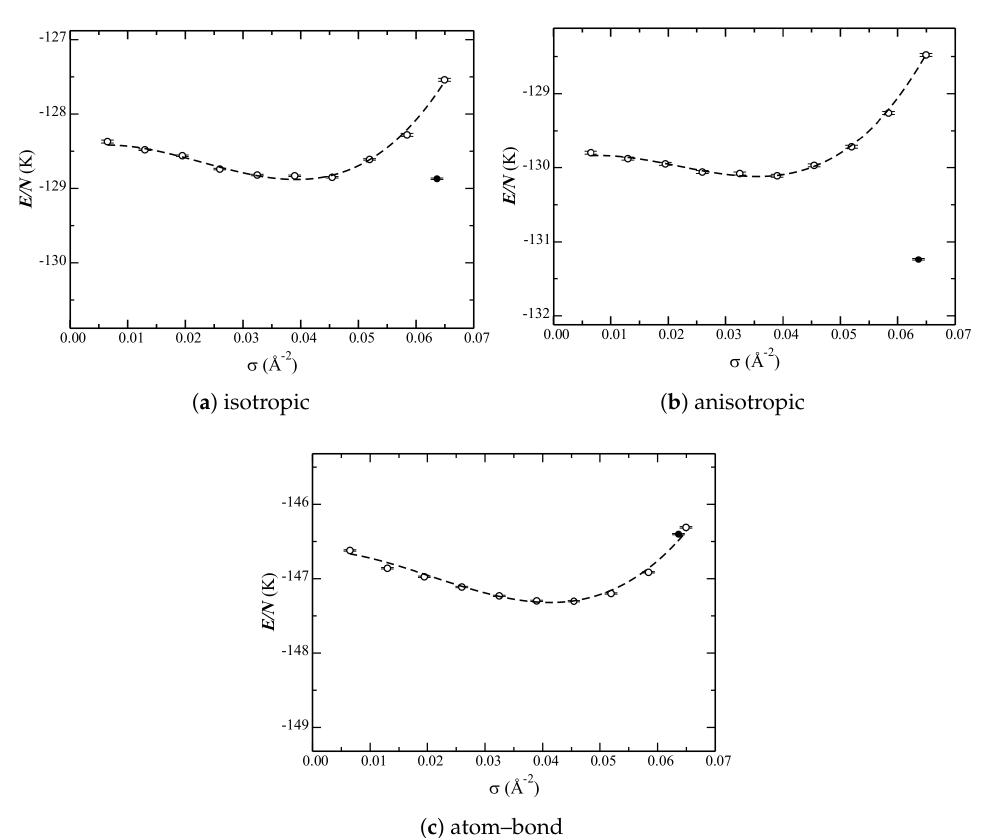
Figure 5. Phase diagram of 4 He adsorbed on graphene. Results are shown for the three He–C potentials under consideration. Open circles correspond to liquid data, the dashed lines are fits to this data (Equation (6)), and filled circles correspond to the C 1/3 phase. Note that ( a ) is the same as in Figure